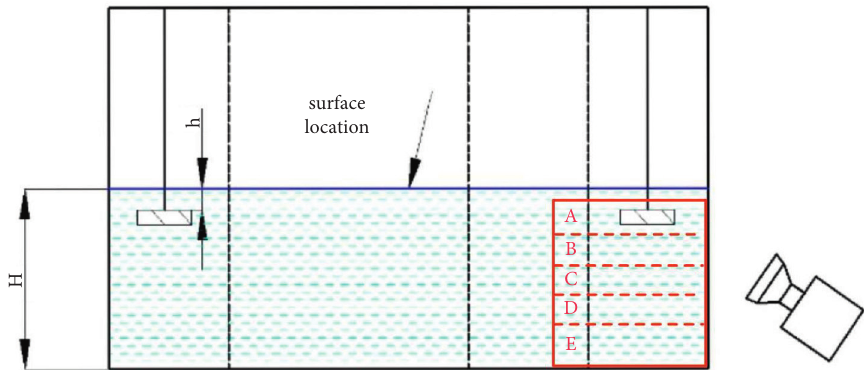
Figure 11: High-speed camera with LED and map of the shooting